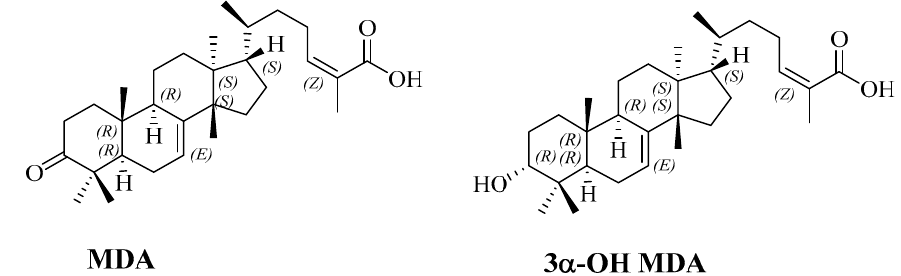
Figure 1. Chemical structures of masticadienonic (MDA) and 3 α -hydroxymasticadienoic (3 α -OH MDA) acids.